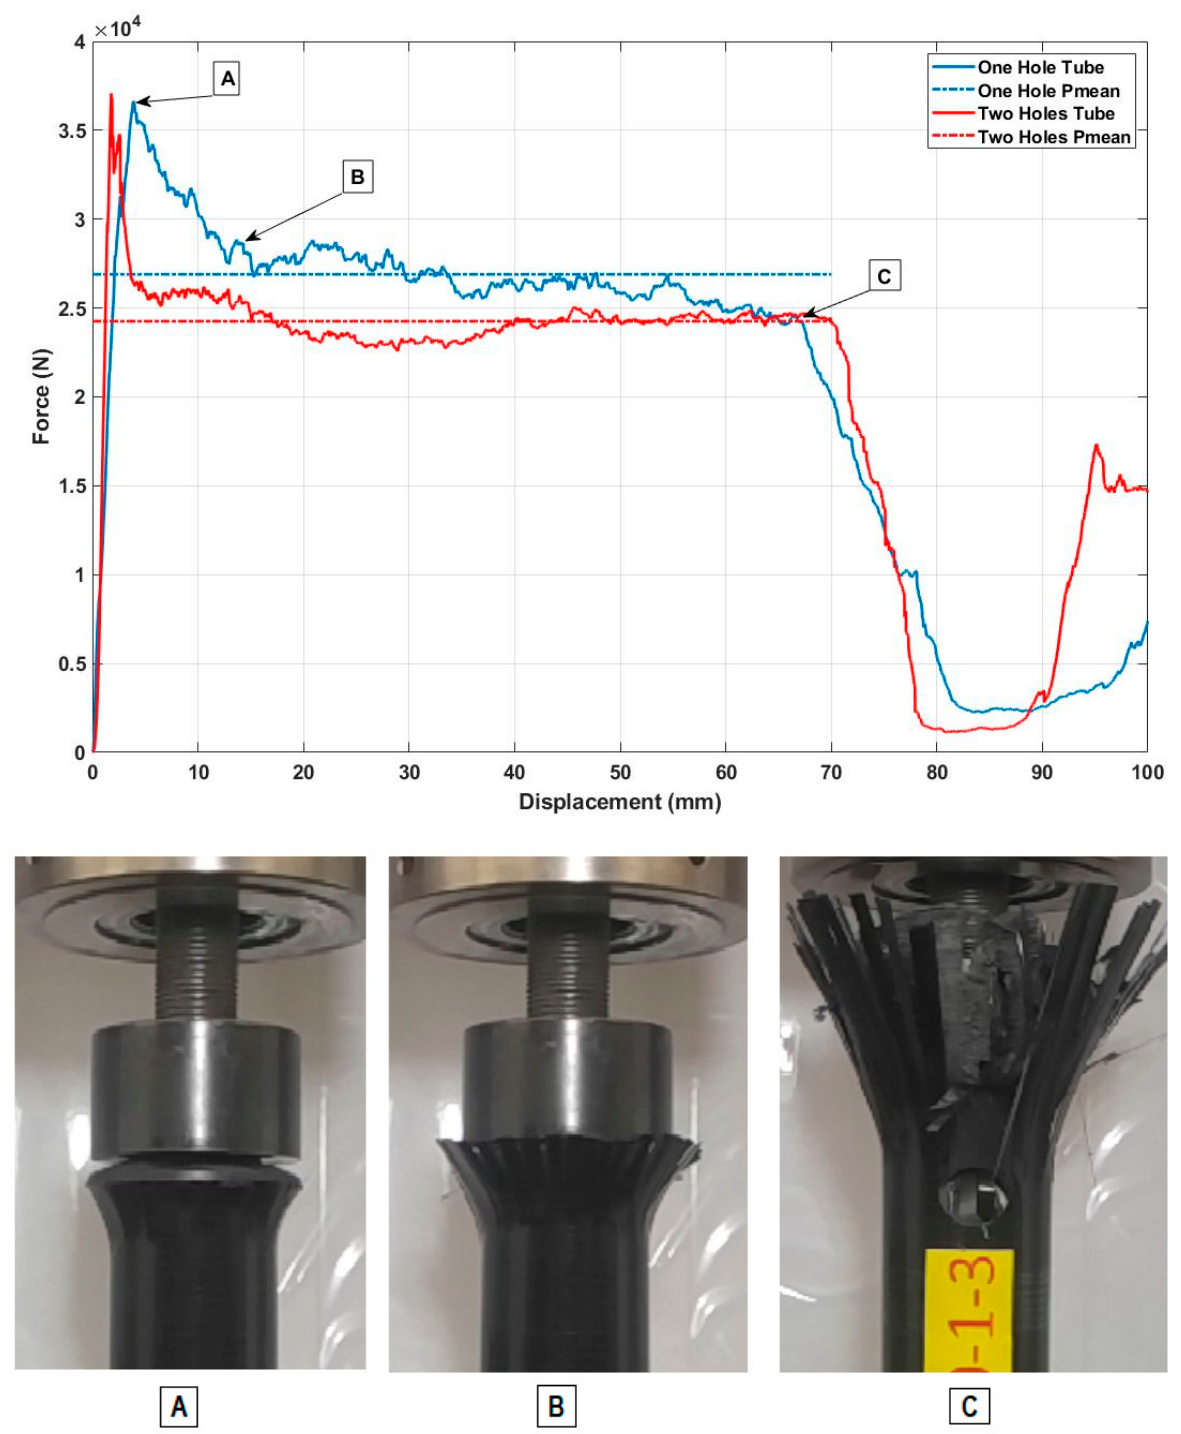
Figure 7. Force–displacement curves for the tubes with 15 mm hole, 100 mm from chamfered top (average).